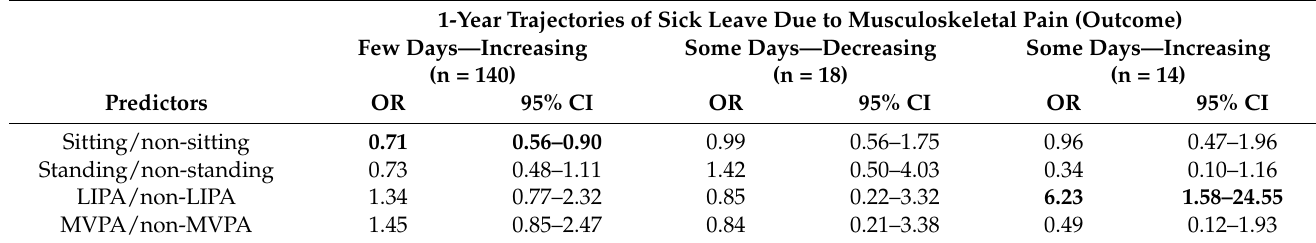
Table 2. Adjusted association between work-time compositions of physical behavior and sick leave due to musculoskeletal pain (reference: no sick leave; n = 571) in 743 workers. Physical behavior data are expressed in isometric log-ratios (ILRs).